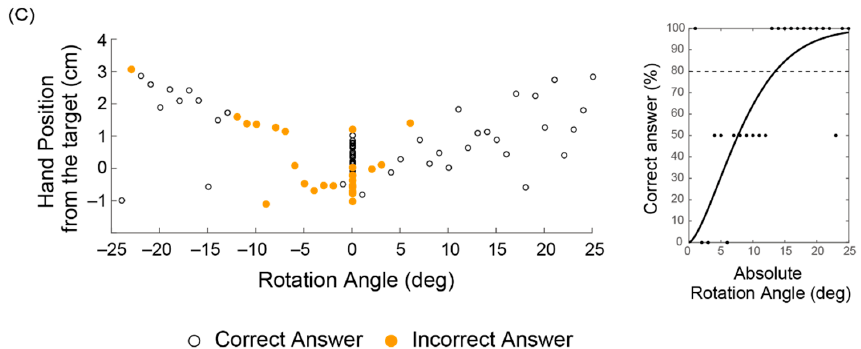
Figure 2. Reaching task results. ( a ) Correctly perceiving a discrepancy in the cursor position as a function of the gap-detection angle between older and younger groups. Psychometric curves with 95% confidence interval fitted using Weibull functions to the pooled group data, wherein the dotted line denotes the threshold of 80% correct discrimination. ( b ) and ( c ) Examples of younger and older representatives, respectively. Reaching hand position ( y -axis) and cursor rotation angles ( x -axis) plotted with correct and incorrect answers in the left panels together with individual fitted curves in the right panels.